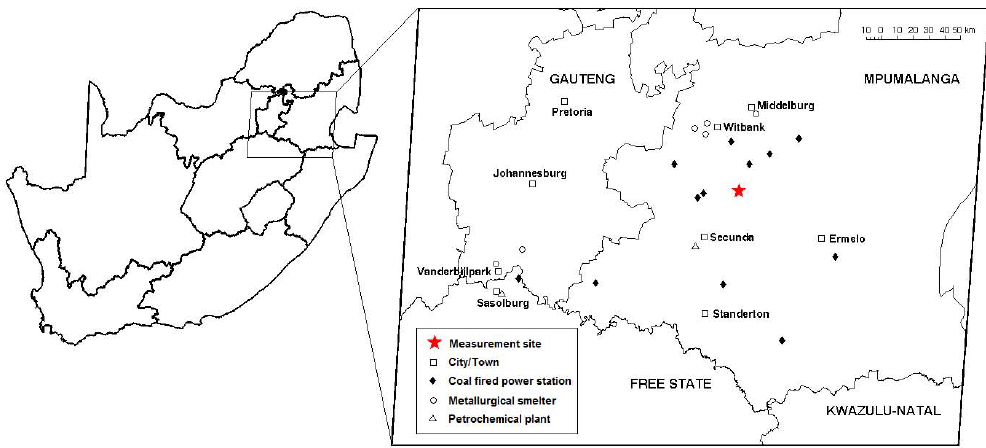
Fig. 4. Surroundings of the measurement site. The measurement site is indicated by a star and the major point sources by symbols described in